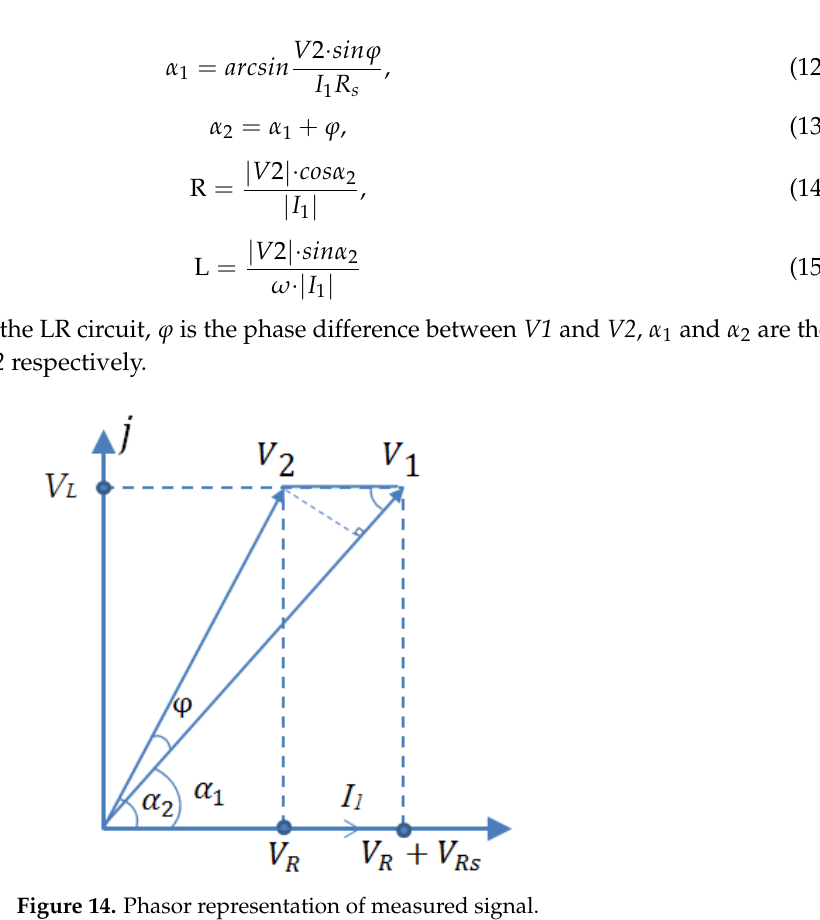
Figure 14. Phasor representation of measured signal.